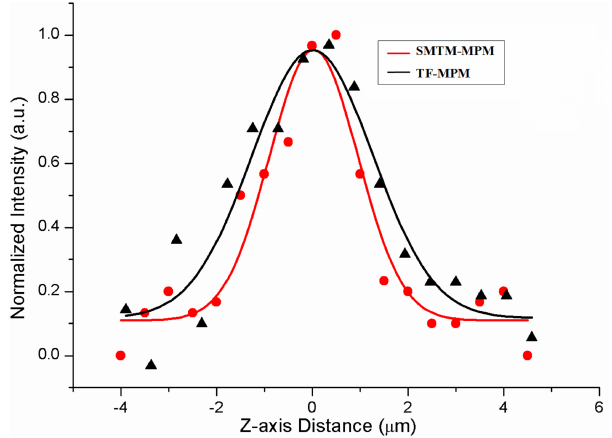
Fig. 3. The °uorescence-intensity pro¯le obtained by scanning a 0.19 (cid:1) m °uorescence bead along the z -axis using (a) our SMTM-MPM (red) and (b) TF-MPM (black).